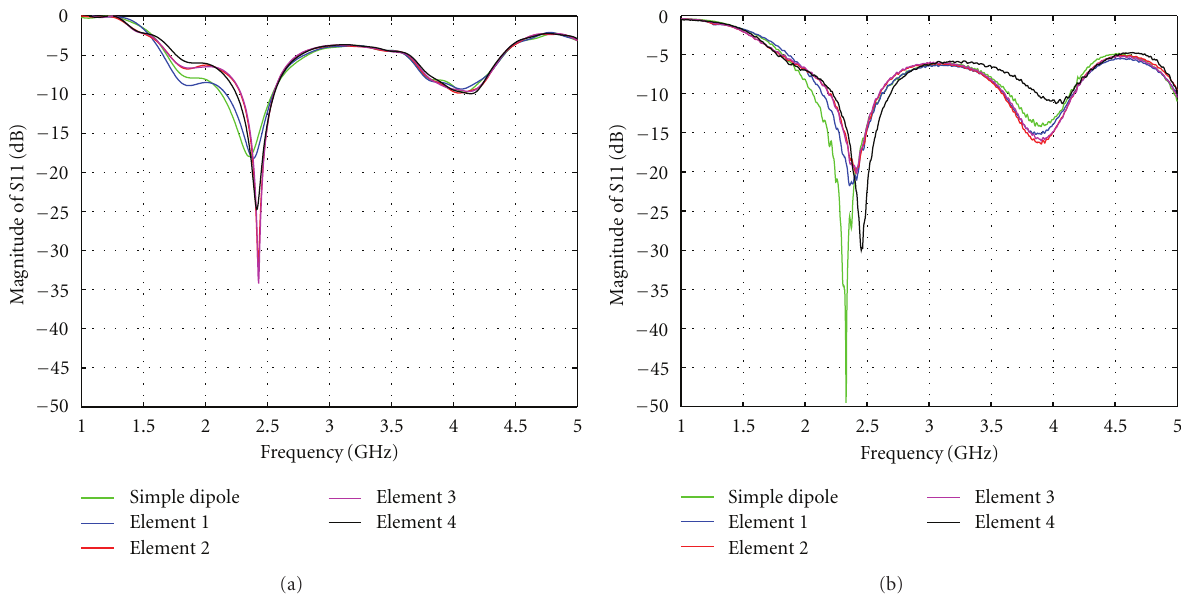
Figure 10: Magnitude of S 11 parameter in single dipole and elements on ULA array structures with reflector: (a) simulated and (b) meas- ured.